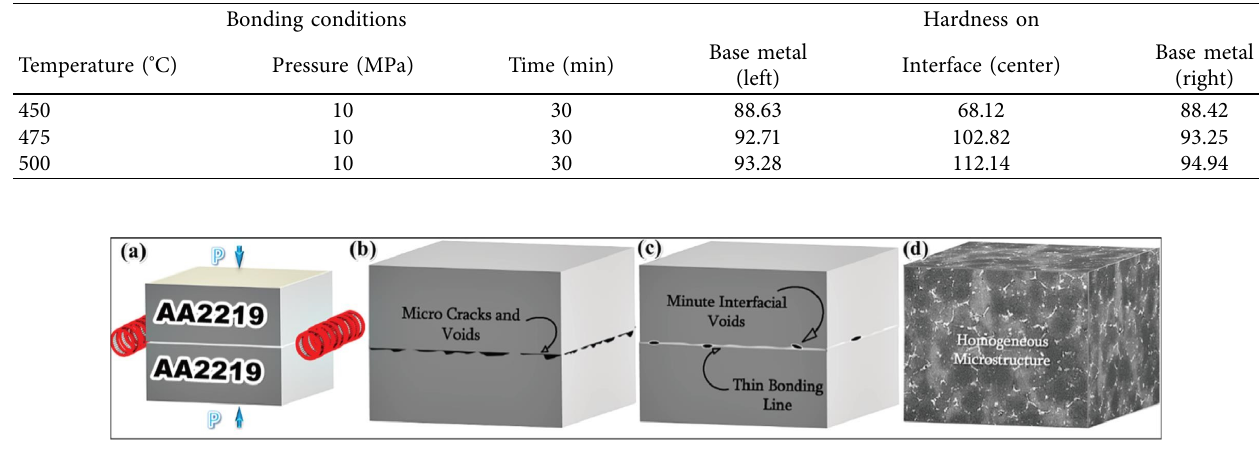
Figure 16: Bonding formations of the AA2219 joints: (a) Specimens before difusion bonding, (b) formation of cracks and voids along the interface at 450 ° C, (c) formation of thin bonding line on the interface at 475 ° C, and (d) formation of the homogeneous microstructure without bonding line at 500 °